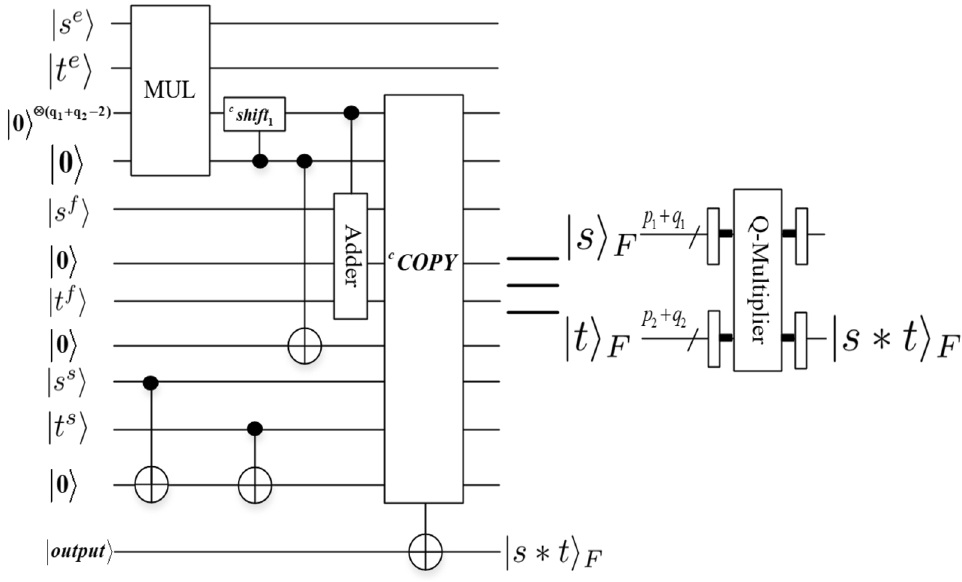
Figure 13. Q -Multiplier module.